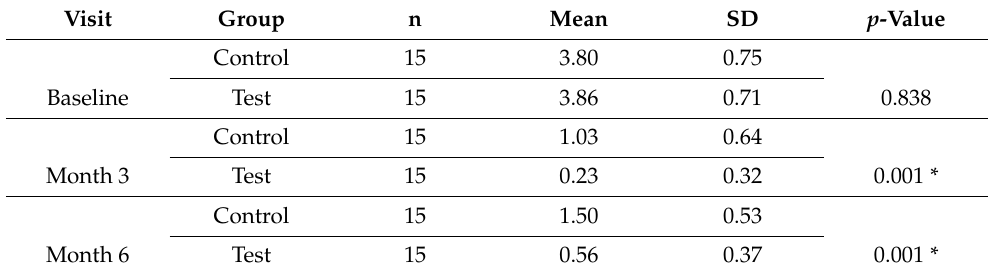
Table 3. Inter-group comparison of gingival recession